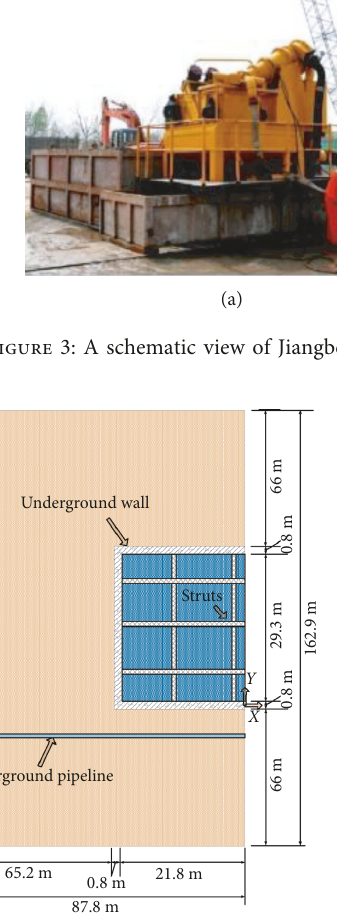
Figure 4: The cross-sectional X - Y simplified model view of the pit.